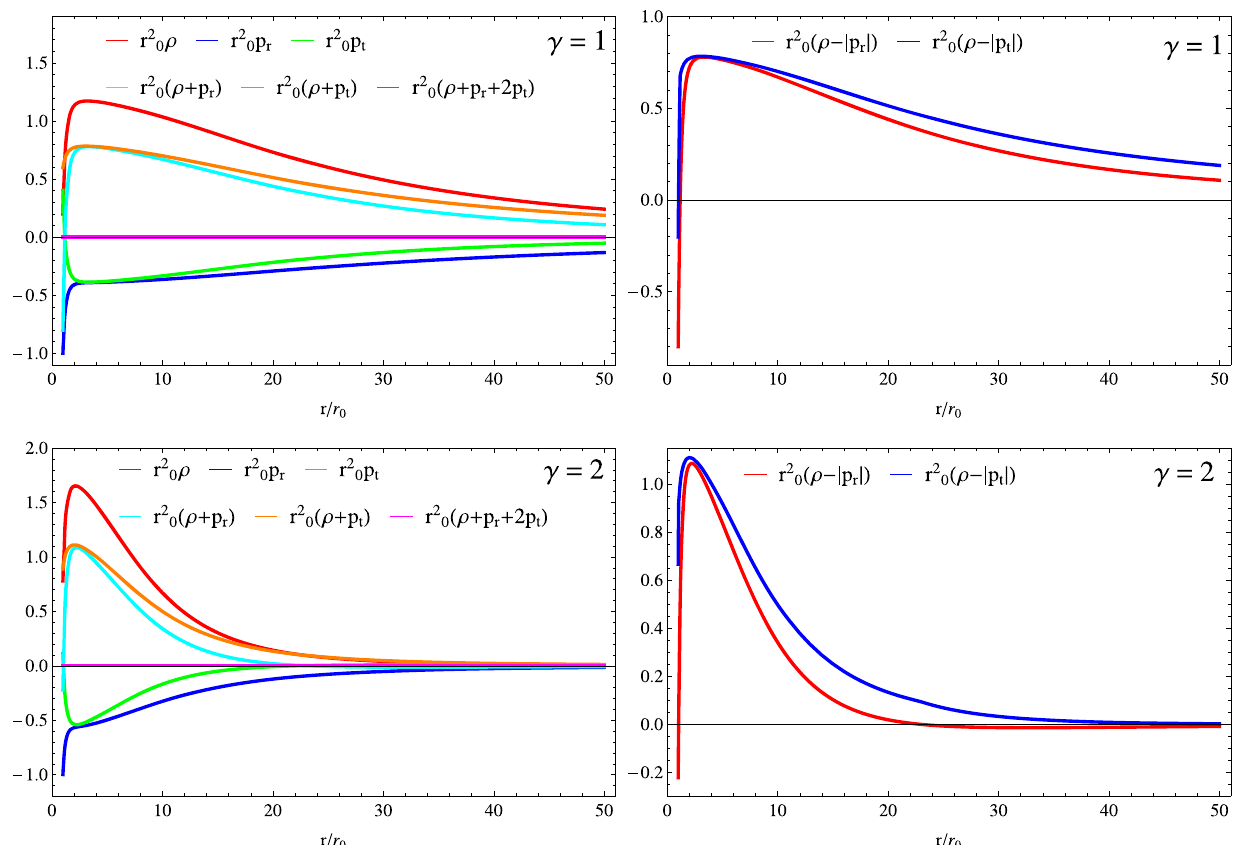
Fig. 8 The thermodynamic variables and energy conditions against the dimensionless variable r / r 0 , for the model #2, taking the numerical data presented in Table